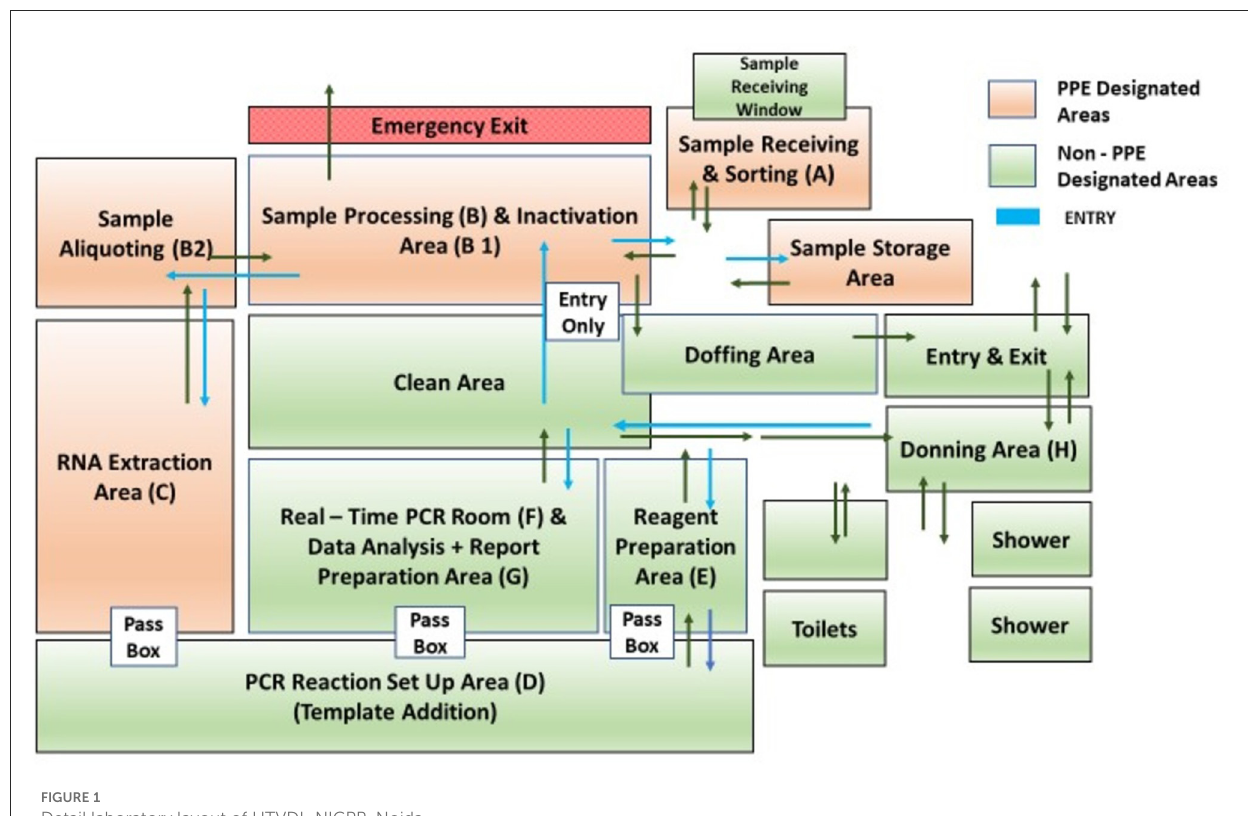
FIGURE1 Detail laboratory layout of HTVDL-NICPR, Noida.